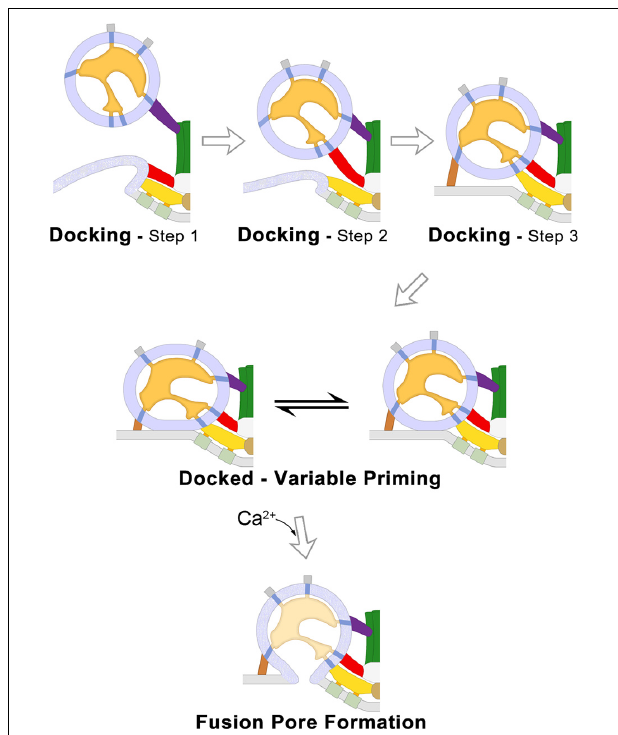
FIGURE 2 | SV trafficking events that lead to neurotransmitter secretion at frog NMJs. 2D schematic diagrams of the SV trafficking events at frog NMJs derived from electrically stimulated terminals and analyzed by electron tomography. The three steps of SV docking are characterized by the distance between the undocked SV to the PM and their connections to specific AZM macromolecules (Top). After an SV is docked it undergoes priming which determines the probability that it will fuse when an electrical impulse arrives; the variable priming model states that priming is regulated by forces exerted by AZM macromolecules, which are variable and in dynamic equilibrium, to destabilize the SV membrane–PM contact site and change the positioning of voltage-gated Ca 2+ -channels in relation to the Ca 2+ -sensor protein embedded in the docked SV membrane (Middle). When sufficient concentrations of cytosolic Ca 2+ bind the sensor protein Synaptotagmin, the SV membrane and PM undergo lipidic membrane fusion to form a pore through which neurotransmitter molecules are secreted to the synaptic cleft (Bottom). Adapted from Szule et al. (2012) and Jung et al.